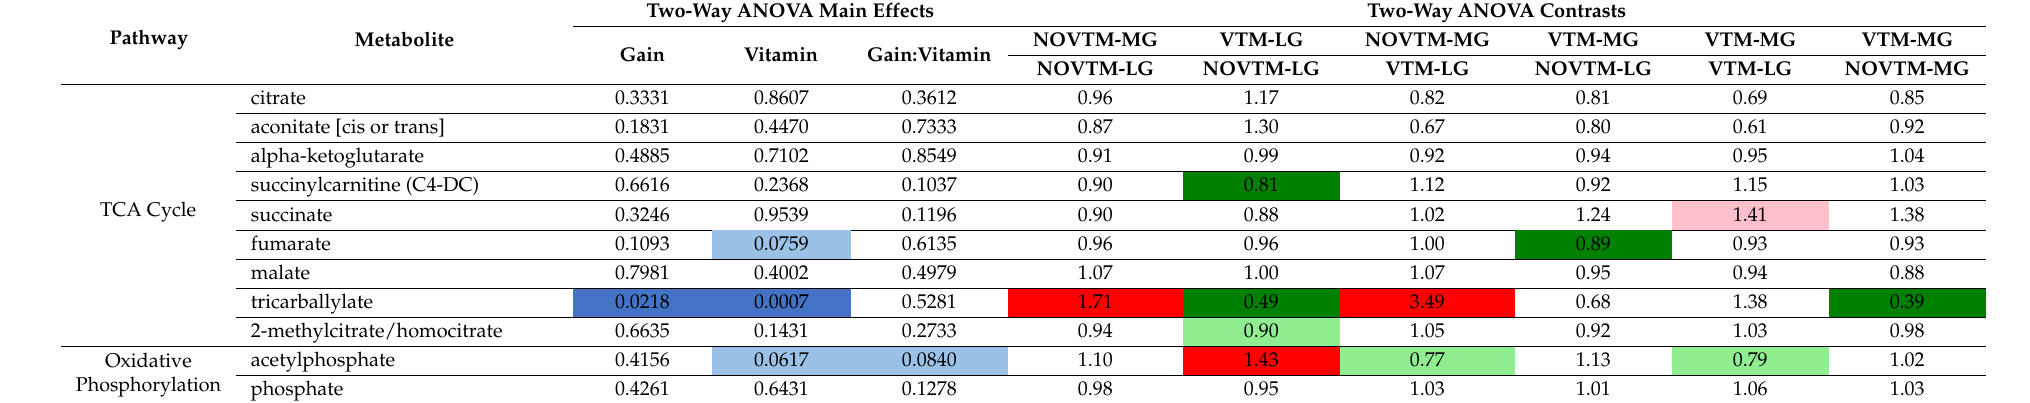
Table 6. Metabolites involved in mitochondrial respiration including: (1) TCA Cycle, and (2) Oxidative Phosphorylation pathways. Pathway